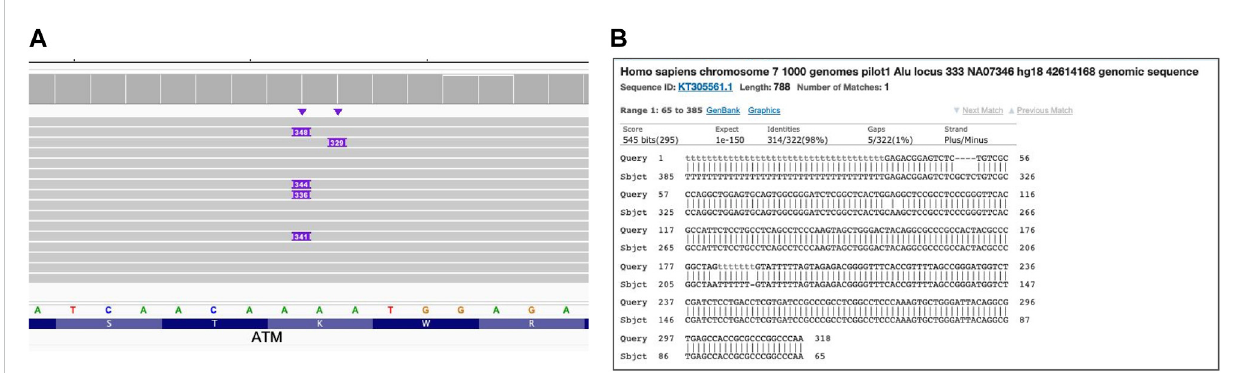
FIGURE 6 Alu mobile element insertion in ATM gene. Long read WGS of sample NA13805. (A) Alignment view Each thick gray horizontal line represents a separate read, with purple rectangles with numbers indicating insertions of the corresponding length (in base pairs). Top of the panel represents a local coverage depth. Purple triangles abovethereadsindicatethelocations oftheinsertion; (B) blast(https://blast.ncbi.nlm.nih.gov/Blast.cgi)results verifying Alu mobile element sequence of the